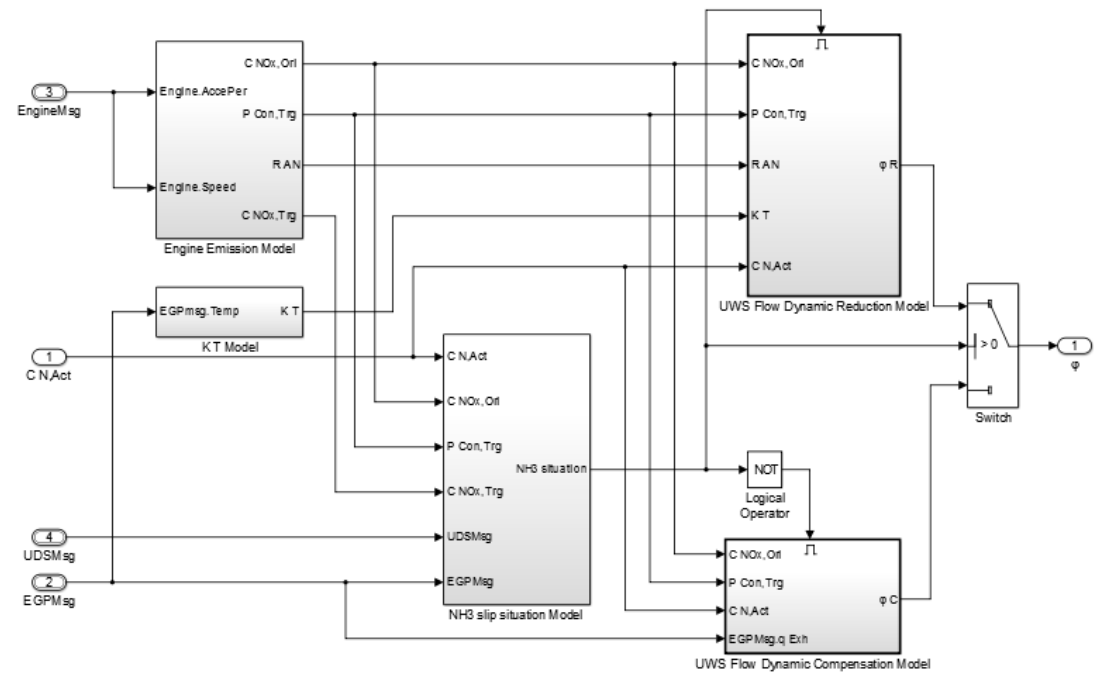
Figure 2. The UWS correction model.